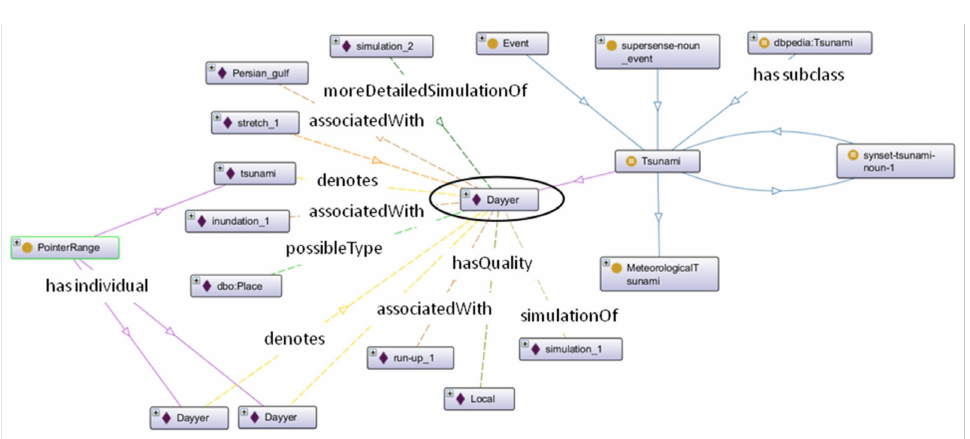
Figure 4. Fragment of the generated ontology (Dayyer in the circle).